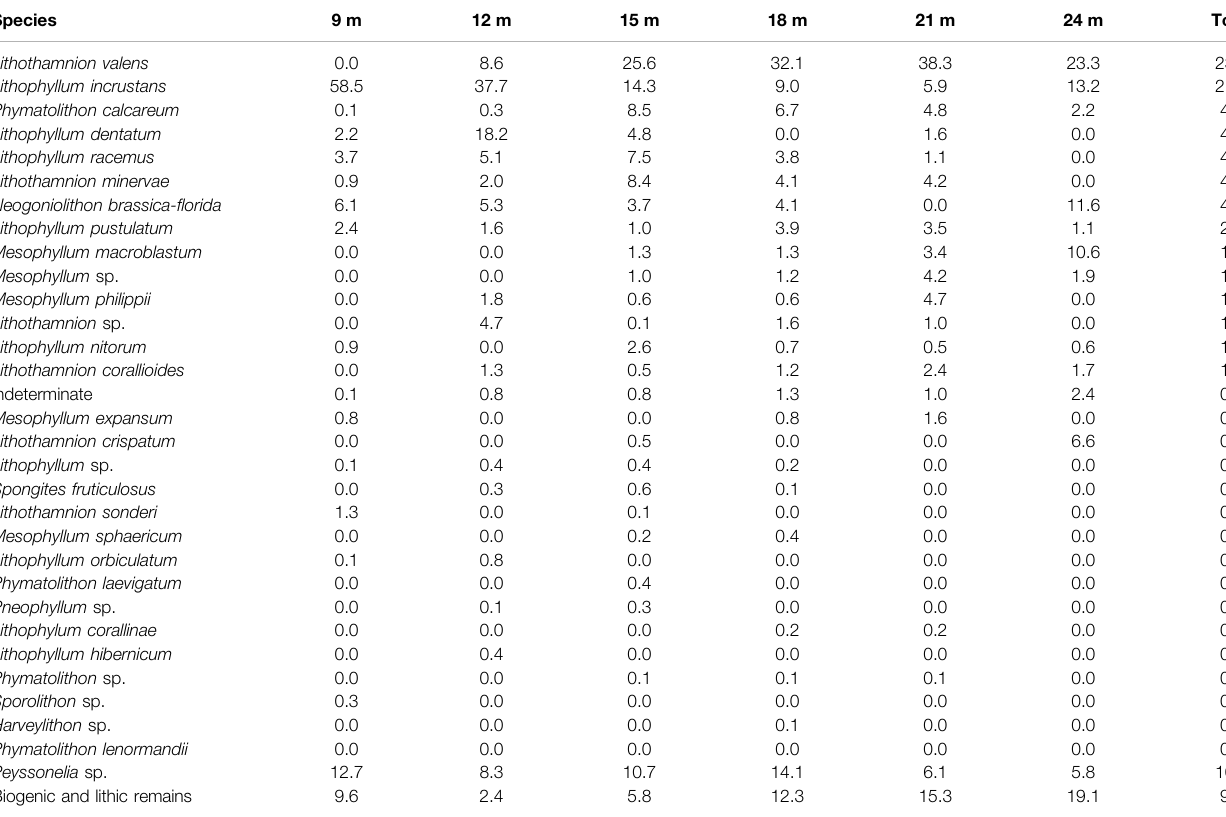
TABLE 1 | Species distribution by depth (%).